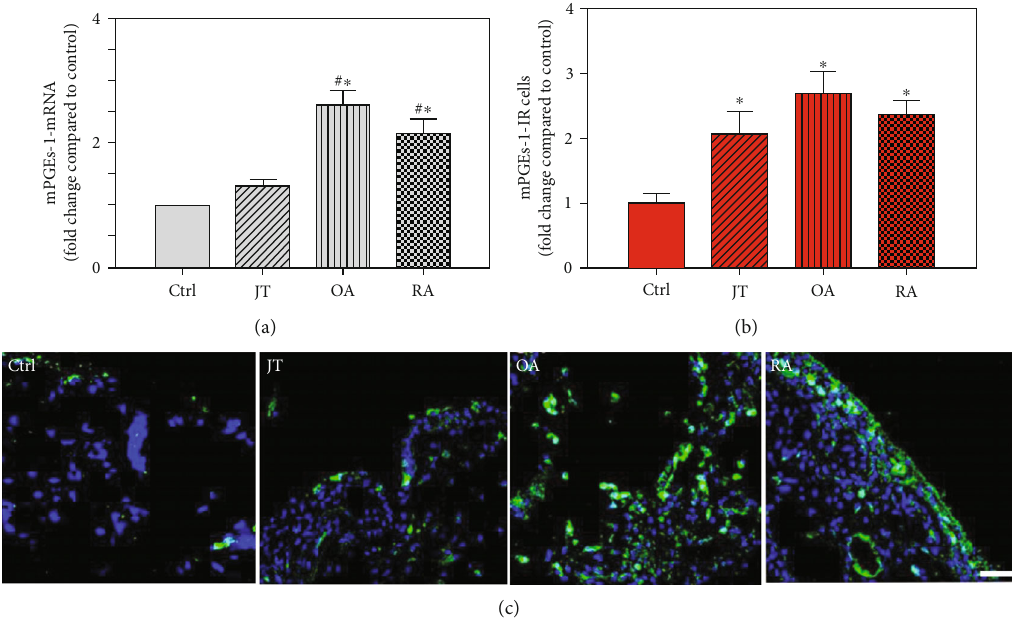
Figure 2: Detection of microsomal prostaglandin E synthase-1 (mPGES-1) mRNA (a) and the number of mPGES-1-IR cells (b) in patients with joint trauma (JT), osteoarthritis (OA) and rheumatoid arthritis (RA). (a, b) Quanti fi cation of mPGES-1 mRNA (a) and immuno fl uorescence positive cells (b) shows that mPGES-1 expression was more prominent in various forms of in fl ammatory joint disease compared to synovium of controls; however, in patients with RA and OA, it was signi fi cantly higher compared to JT (Data are shown as means ± SEM , P < 0 : 05 , one-way ANOVA followed by Tukey ’ s test). C: Immuno fl uorescence microscopy for mPGES (FITC green fl uorescence) shows that the number of synovial mPGES-IR cells is increased in various forms of in fl ammatory joint disease compared to controls which was highest in osteoarthritic synovium. DAPI blue fl uorescence shows nuclear staining. Bar = 20 μ m . ( ∗ P < 0 : 05 , compared to control; # P < 0 : 05 , compared to JT